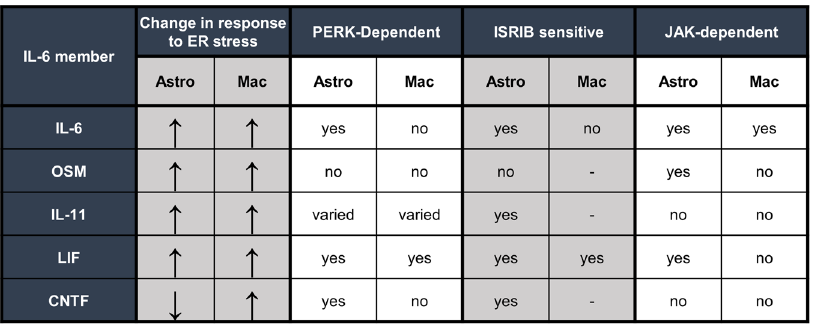
Figure 9. Summary of ER stress-induced regulation of the IL-6 family of cytokines in astrocytes and